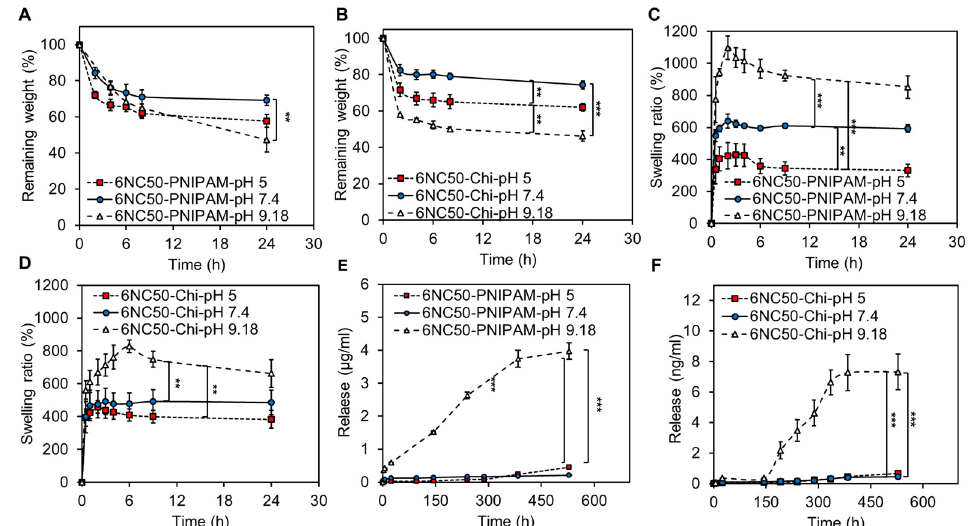
Figure 4. Release related experiments. Degradation, swelling, and release of Rd increases by increasing pH from 5 to 9. Degradation of ( A ) 6NC50-PNIPAM and ( B ) 6NC50-Chi at different pH; Swelling kinetics of ( C ) 6NC50-PNIPAM and ( D ) 6NC50-Chi at different pH. The highest swelling degree for both types of gel was observed in pH 9.18; cumulative Rd release from ( E ) 6NC50-PNIPAM and ( F ) 6NC50-Chi over the span of 22 days in different pH. The release was significantly higher (*** p < 0.001) in pH 9.18 respect to other